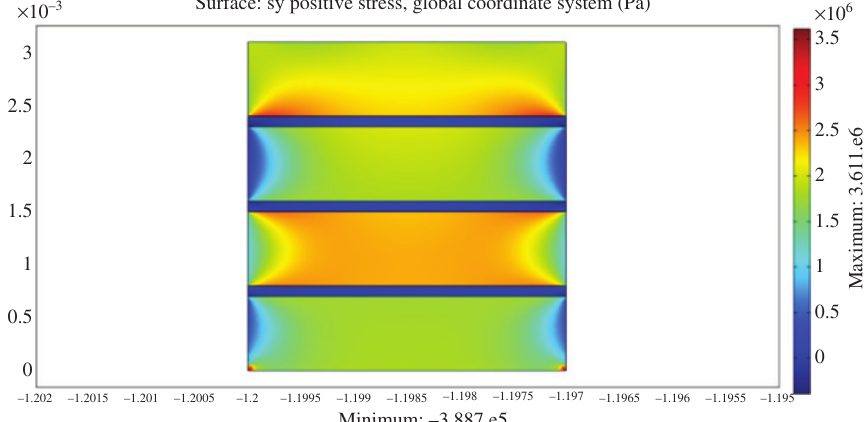
Figure 4: Charging initial electric displacement ( D = 140 C/m 2 ).